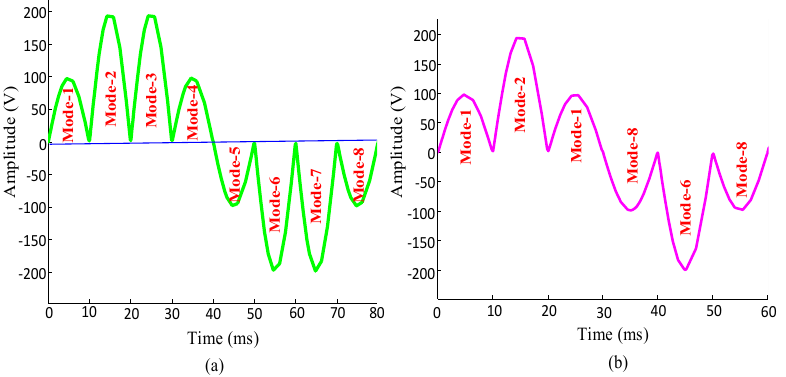
Figure 4. Expected output response for ( a ) one − fourth frequency conversion and ( b ) one − third frequency conversion of proposed cycloconverter.